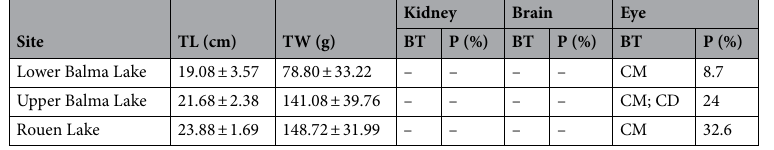
Table 1. Total length (TL; cm), total weight (TW; g), and results of bacteriological examination (MALDI- TOF MS; ID: 99.9%) of kidney, brain, and eye of fish from the three lakes. Plus-minus values are the mean ± standard deviation. BT = bacteriological test; P (%) = prevalence of bacteria colonization in percentage; CM = Carnobacterium maltaromaticum ; CD = Carnobacterium divergens .